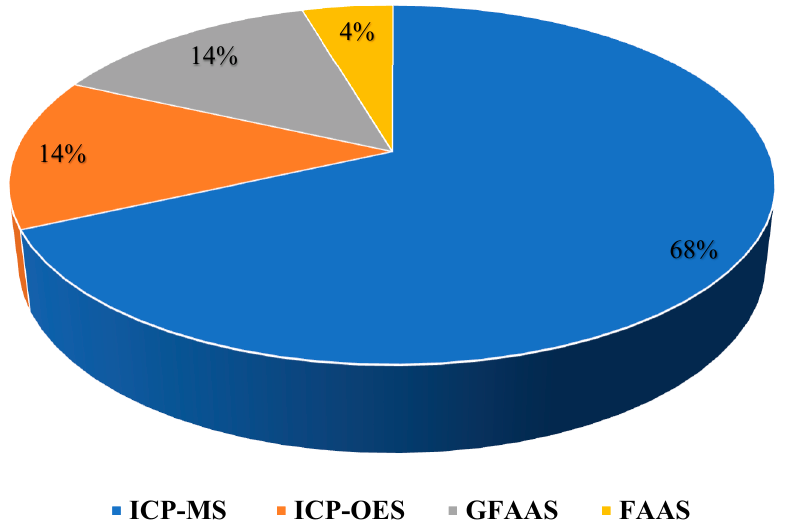
Figure 5. Percentage of articles that use atomic spectroscopic techniques to analyse trace elements in olive oil.